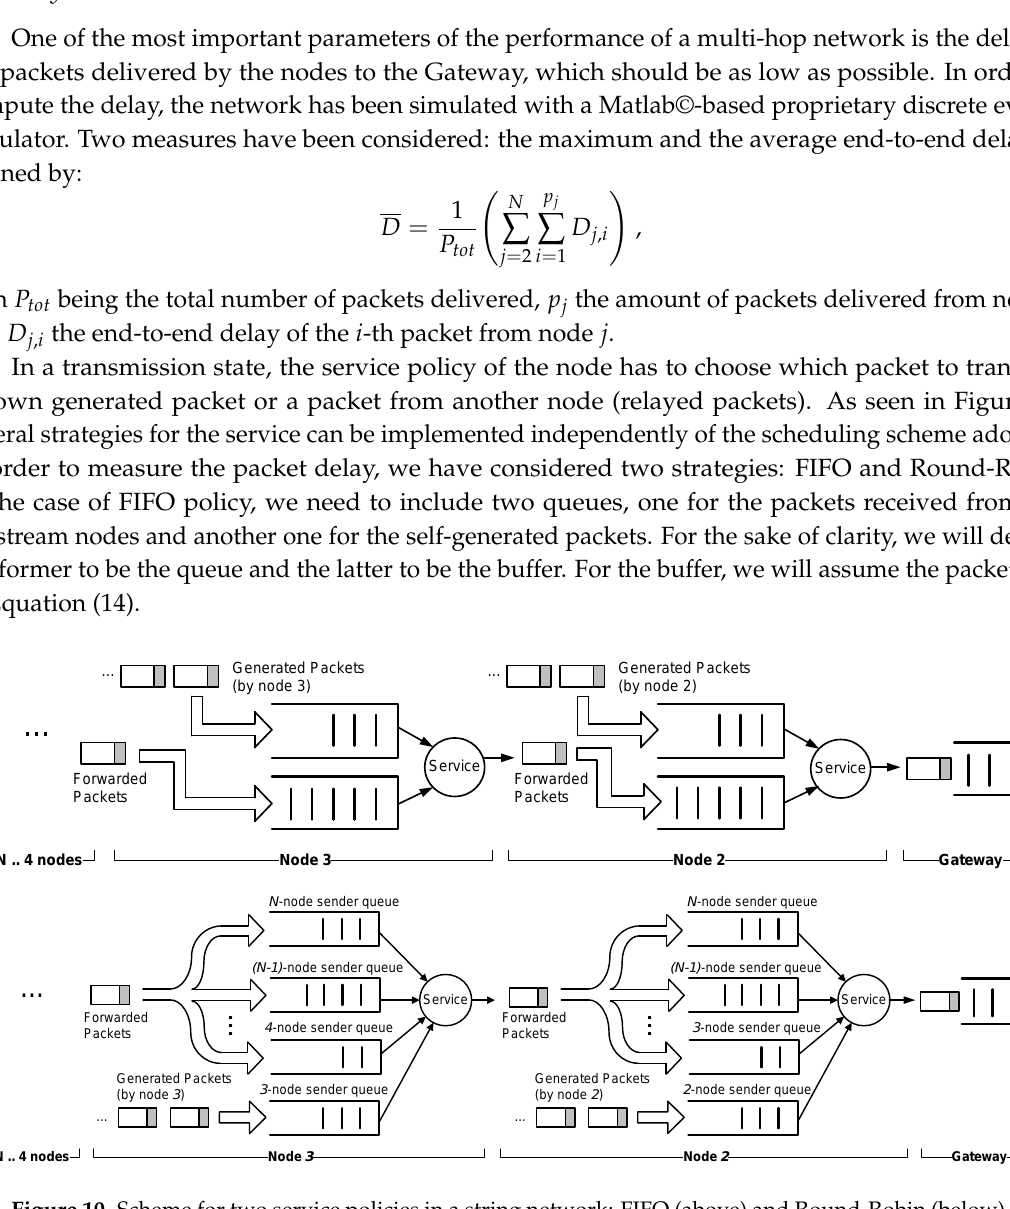
Figure 10. Scheme for two service policies in a string network: FIFO ( above ) and Round-Robin ( below ).